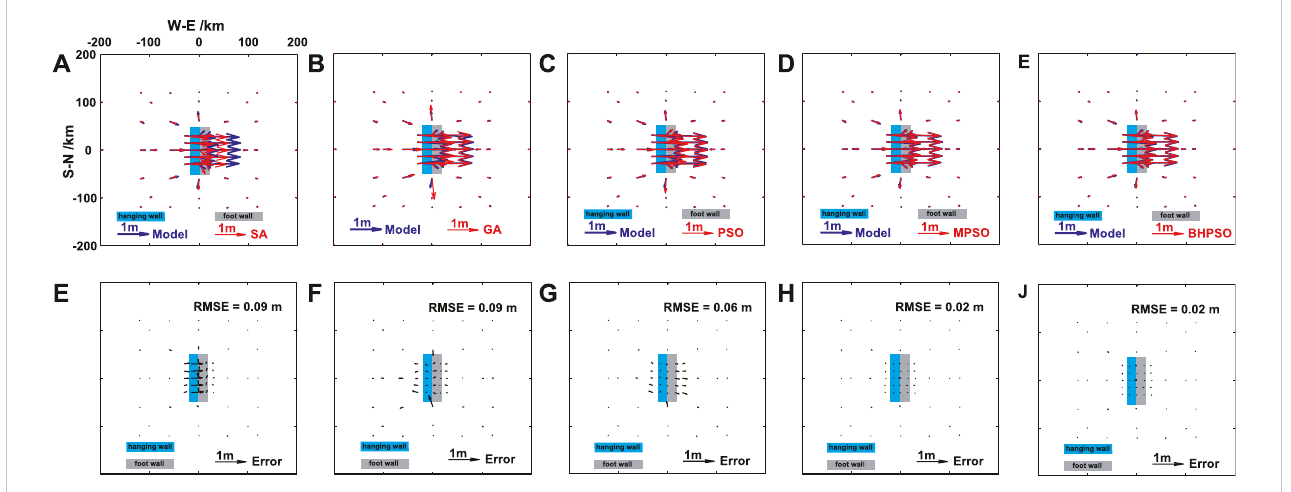
The comparisons of surface horizontal deformation (GPS data) of the Okada model results from the pure dip-slip fault earthquake by using fault parameters given by the model and inversed from fi ve methods in Table 2. The surface horizontal deformation obtained by model and SA method (A) , model and GA method (B) , model and PSO method (C) , model and MPSO method (D) , and model and BHPSO method (E) . The residual of surface horizontal deformation between the results of model and SA method (F) , model and GA method (G) , model and PSO method (H) , model and MPSO method (I) , model and BHPSO method (J) . The blue arrows show the simulated surface horizontal deformation by the model in Table 2. The red arrows show the simulated surface horizontal deformation by using the fault parameters inversed from the fi ve methods. The black arrows show the fi tting residuals.